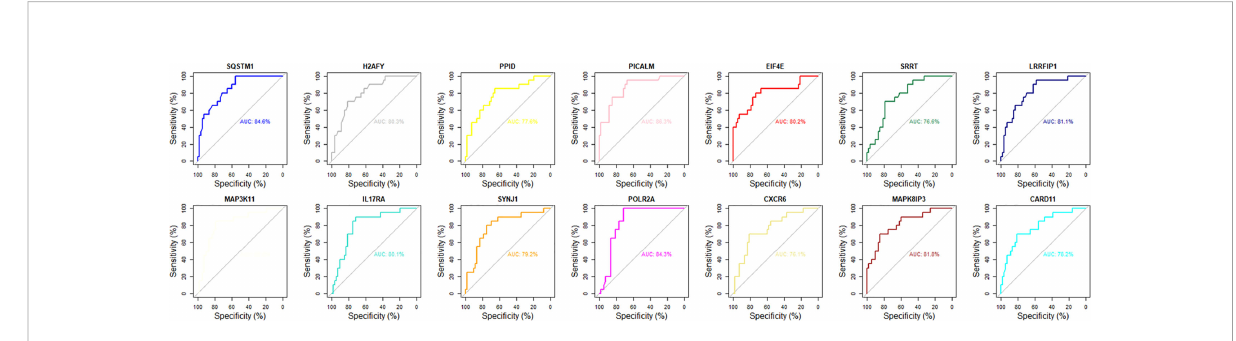
FIGURE 3 The ROC curve analysis of 14 key mRNAs in diagnostic speci fi city for